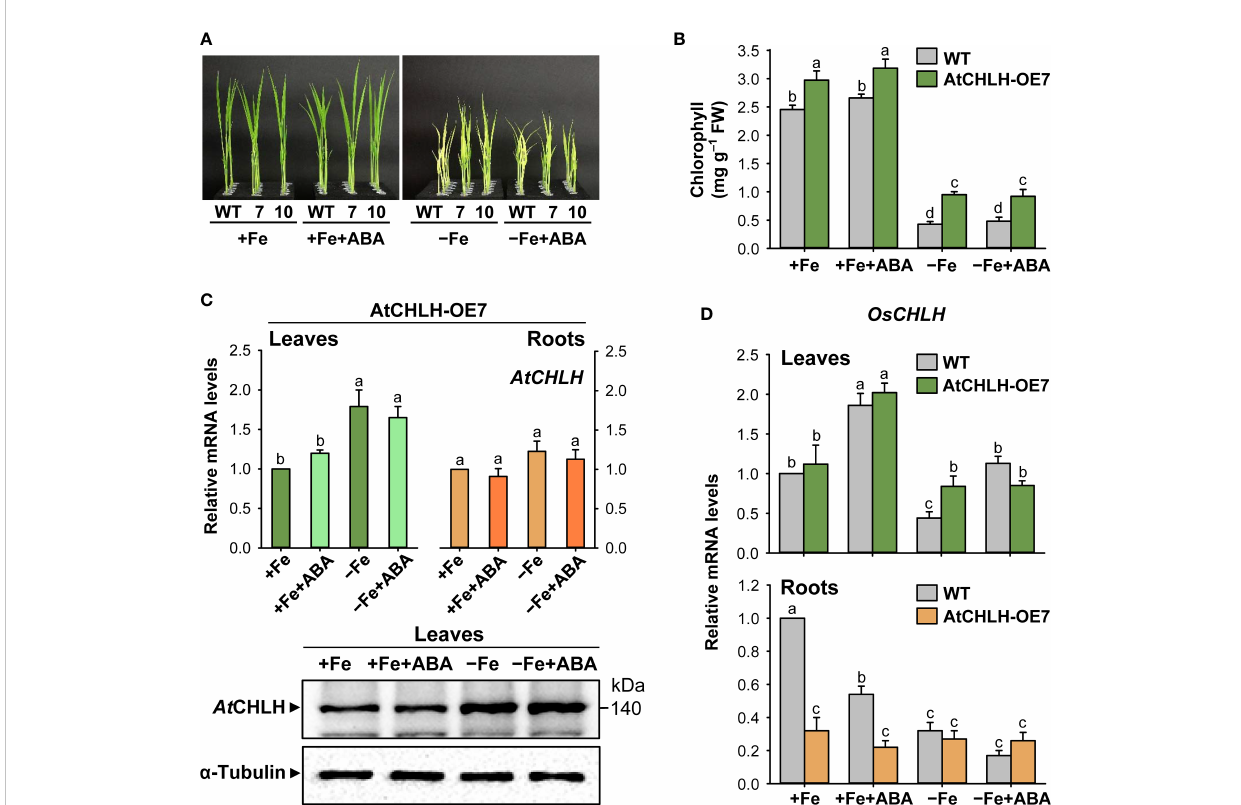
FIGURE 8 Effect of exogenous ABA on Fe de fi ciency responses and regulation of CHLH. (A) Representative phenotypes of Fe-suf fi cient and Fe-de fi cient WT and transgenic plants without or with ABA treatment. (B) Chlorophyll contents. (C) AtCHLH transcript levels and At CHLH protein abundance in transgenic plants. Alpha - tubulin was used as a loading control in immunoblot analysis. (D) OsCHLH transcript levels in leaves and roots of WT and transgenic plants. The general steps performed during the RT-qPCR experiment, from RNA isolation to data analysis, are outlined in Figure 4. WT and transgenic plants were grown in half-strength Hoagland solution with 50µM Fe-EDTA (+Fe) or no Fe-EDTA ( – Fe) for 3 days. Then, Fe-suf fi cient WT and transgenic seedlings were transferred to solutions without or with 0.5 µM ABA for 7 days: +Fe or +Fe+ABA. Fe-de fi cient WT and transgenic seedlings were also transferred to solutions without or with 0.5 µM ABA for 7 days: – Fe or – Fe+ABA. Values are means ± SE, and data from three independent experiments are presented. Different letters indicate signi fi cant differences at P < 0.05 by Duncan ’ s multiple range